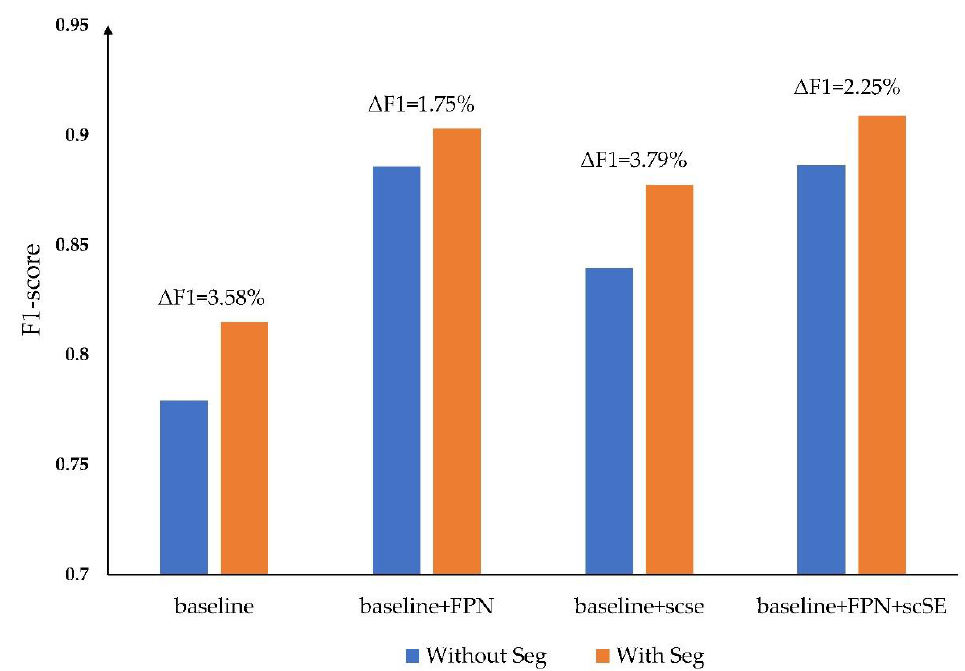
Figure 8. Comparison of F1-scores with and without semantic segmentation branches under different baseline models.